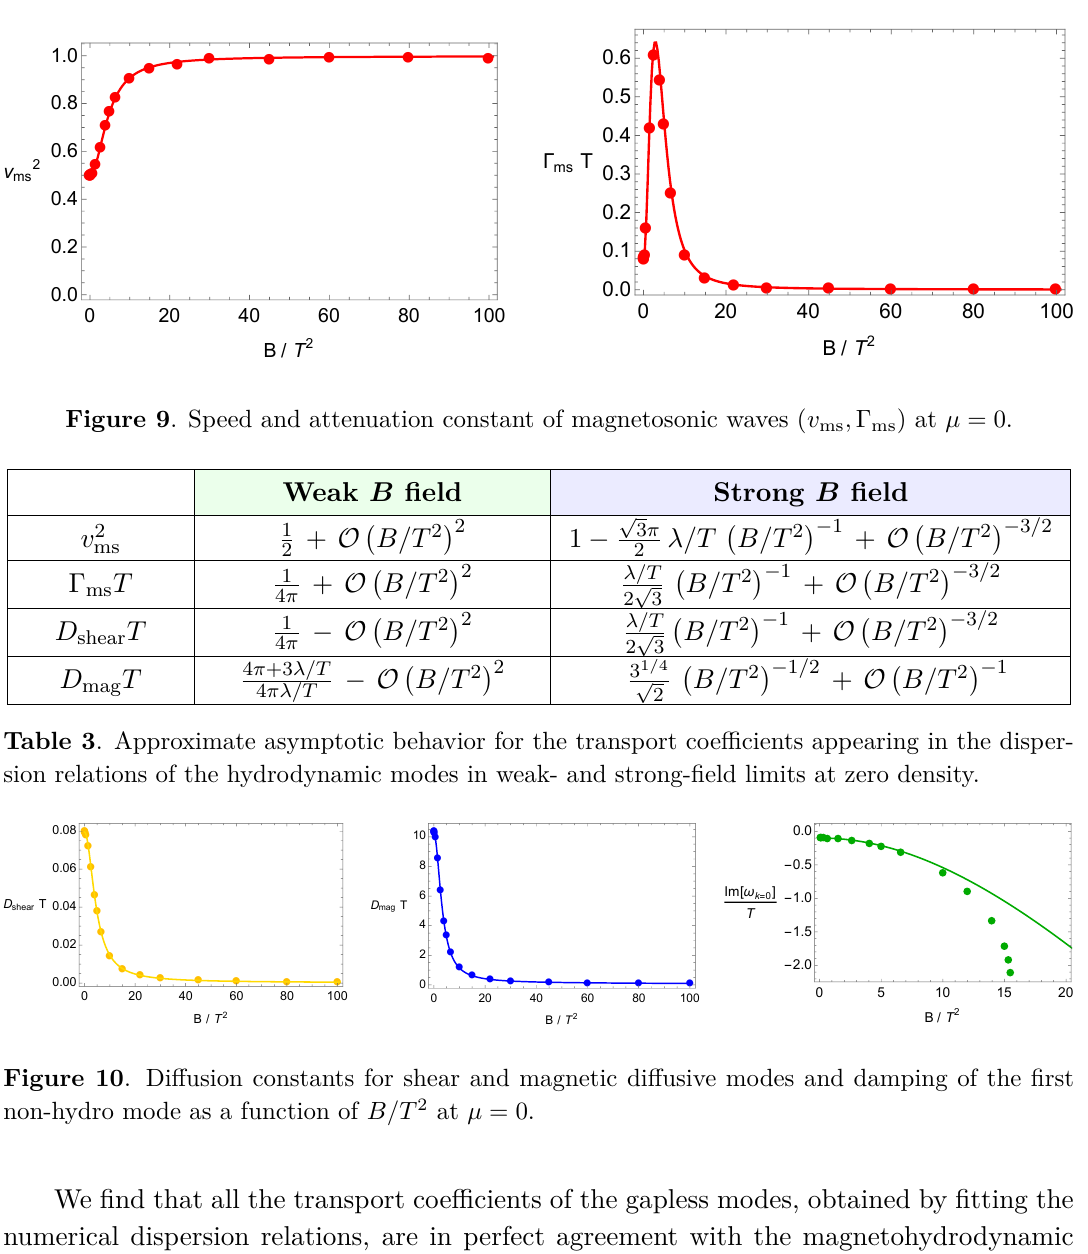
Figure 10 . Diffusion constants for shear and magnetic diffusive modes and damping of the first non-hydro mode as a function of B/T 2 at µ = 0